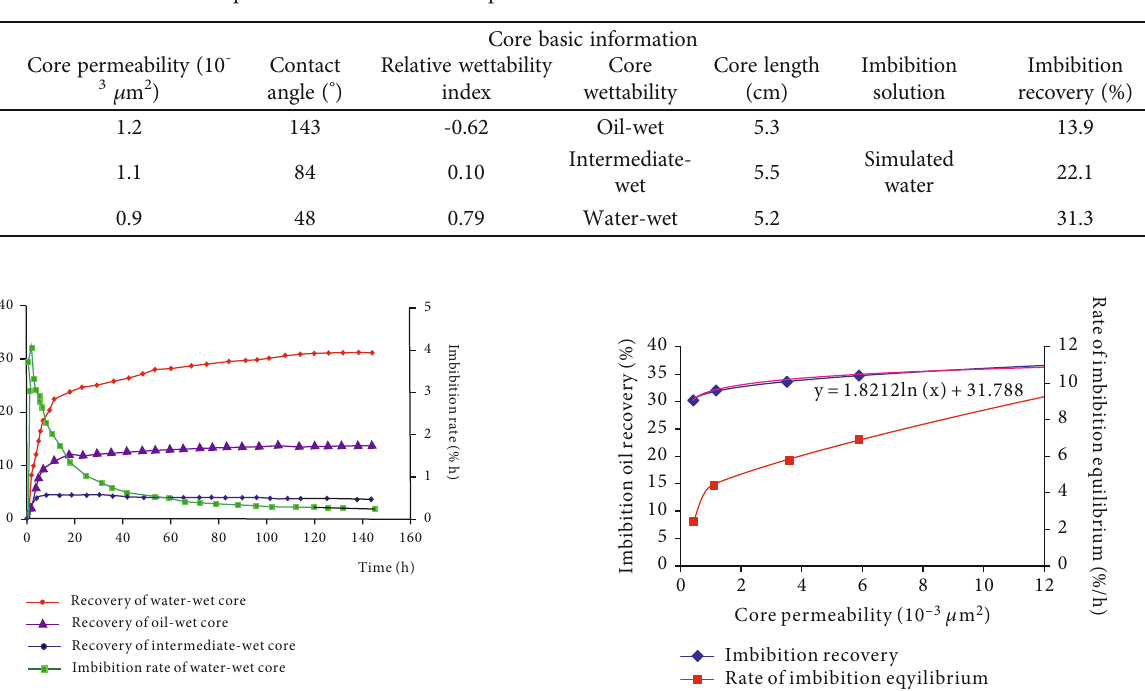
Table 2: Experimental results of static spontaneous imbibition under di ff erent wettabilities.